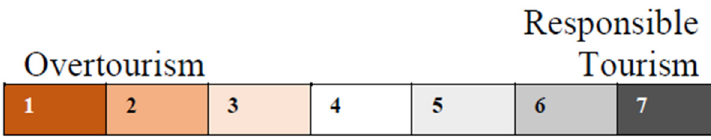
Figure 6. Holistic tourism development spectrum. Source : Adapted from Akbulut and Ekin [29]. Proper management of overtourism requires that all the aforementioned be periodi-